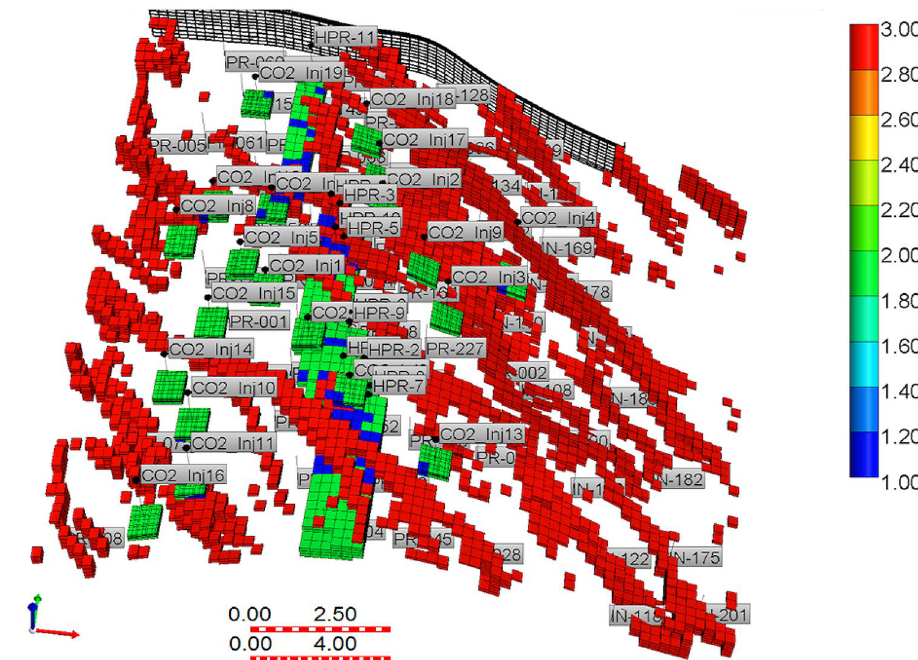
Fig. 4 Production and injec- tion well locations in high- permeable regions (sand and shaly-sand). The reservoir body is represented by a red color, which denotes to shale zones. However, the perforations of producers and injectors were mainly placed in sand (indica- tor number 2) and shaly-sand (indicator number 1) regions of high permeability levels